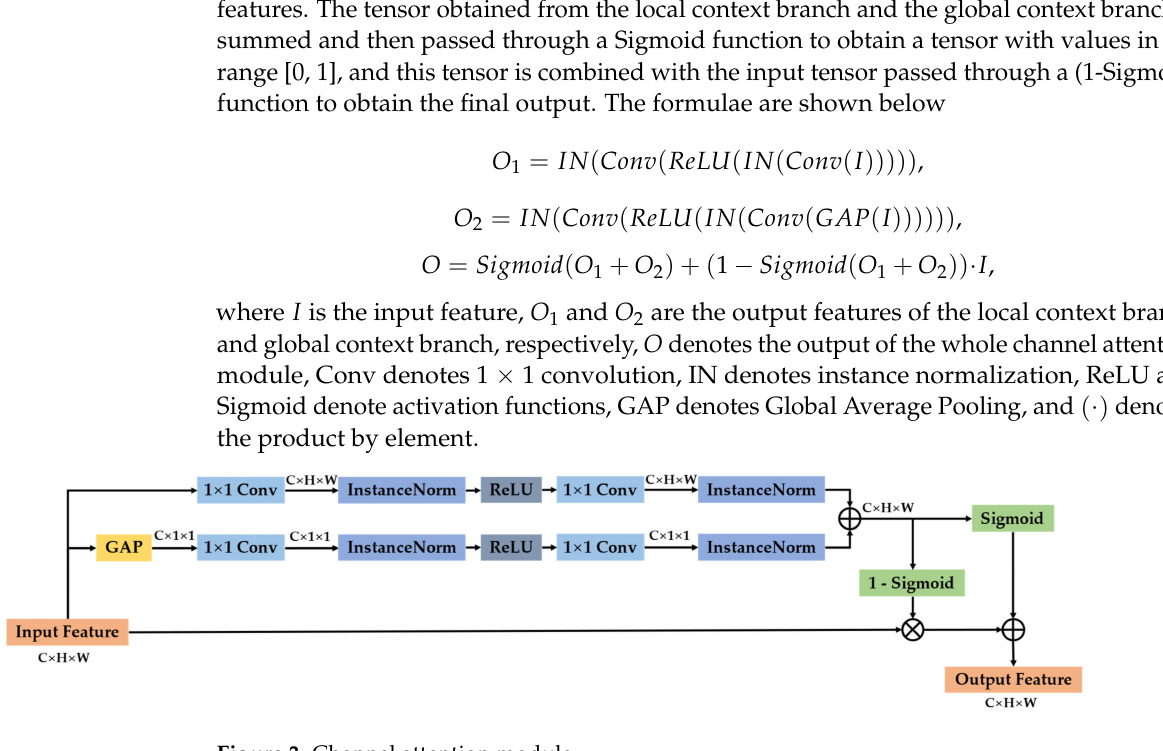
Figure 3. Channel attention module.